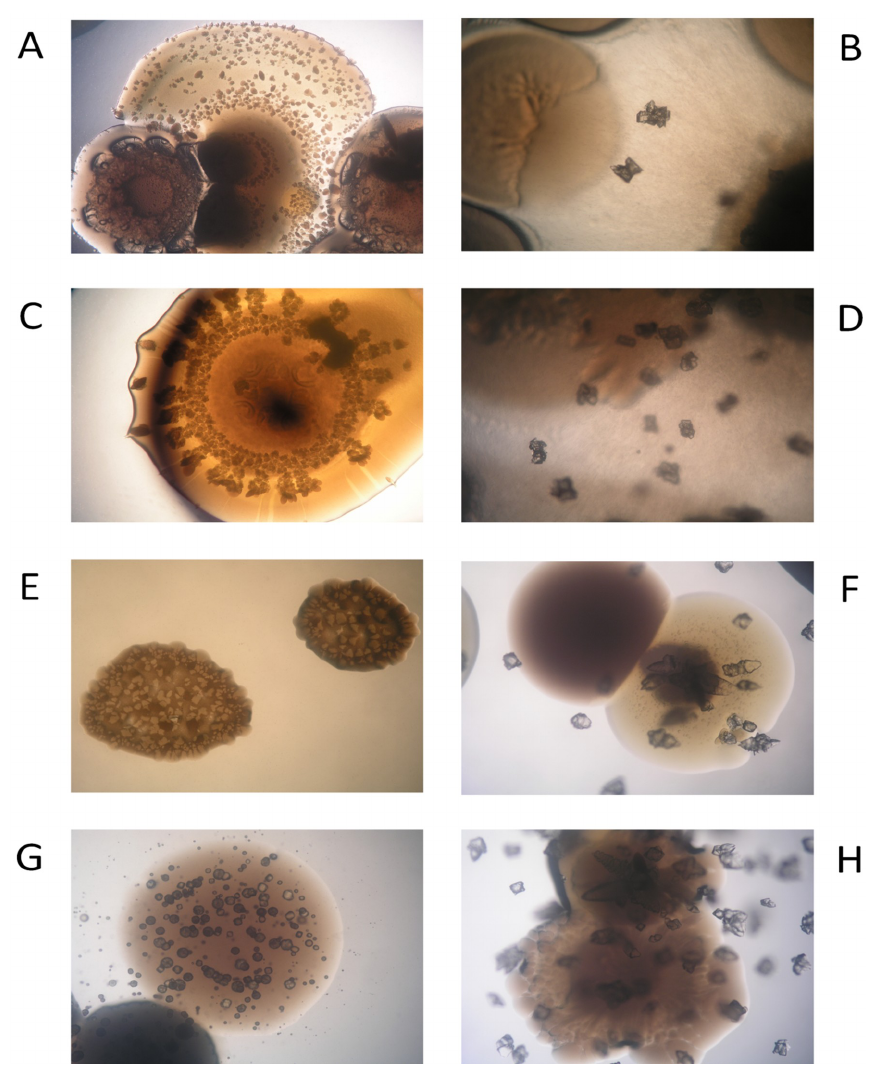
Figure 4. Optical microscopy images of biomineralization in culture media: ( A , C ) MC medium for constant salinity scenario, ( E , G ) MC medium for variable salinity scenario, ( B , D ) ME medium for constant salinity scenario, and ( F , H ) ME medium for variable salinity scenario.